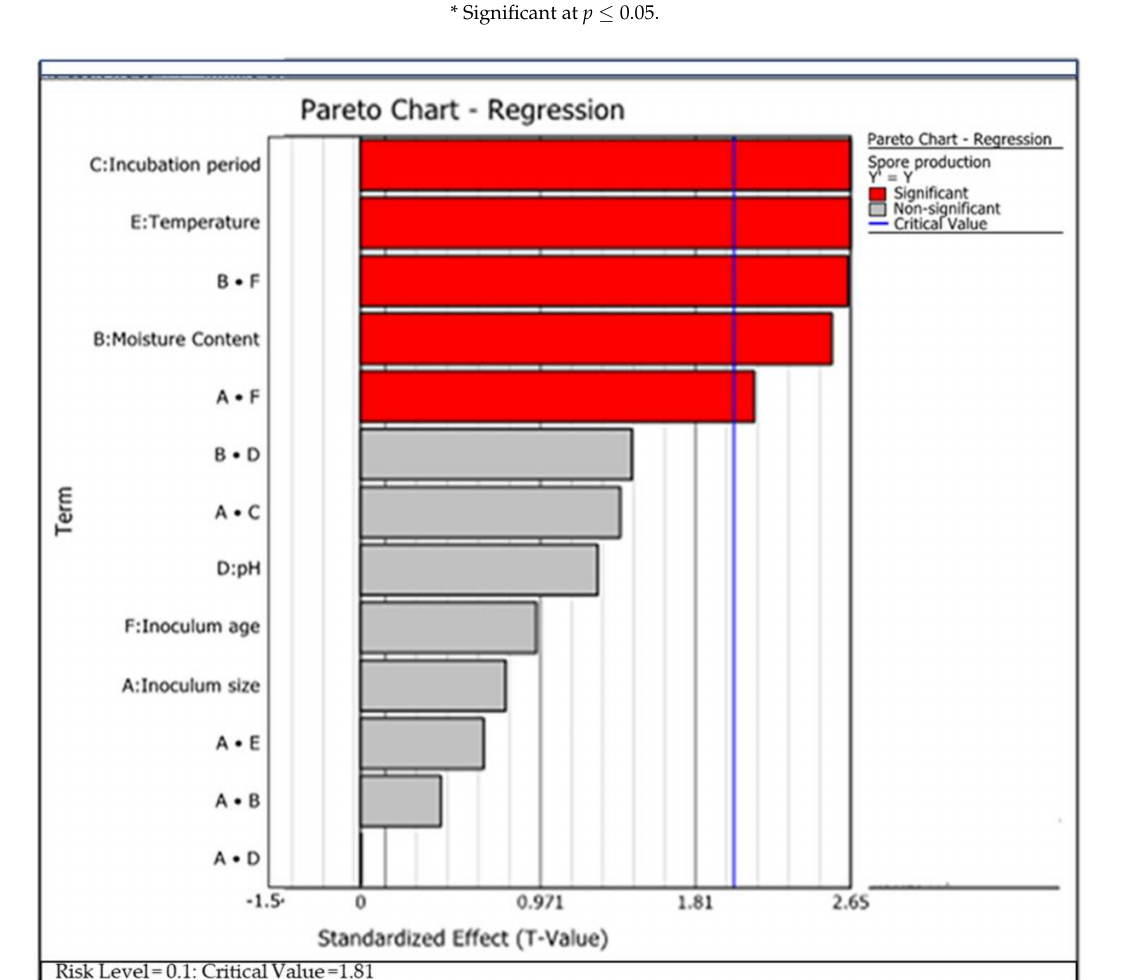
Figure 3. Pareto regression graph indicating the effect of growth factors on conidia production by T. asperellum